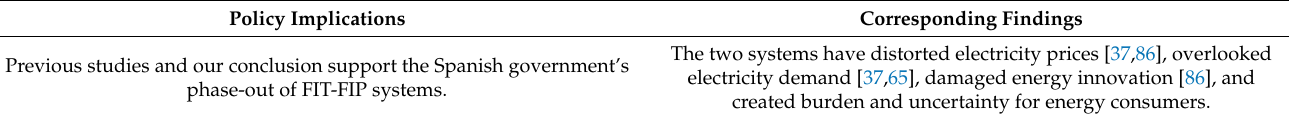
Table 5. The comparison between policy implications and the corresponding empirical